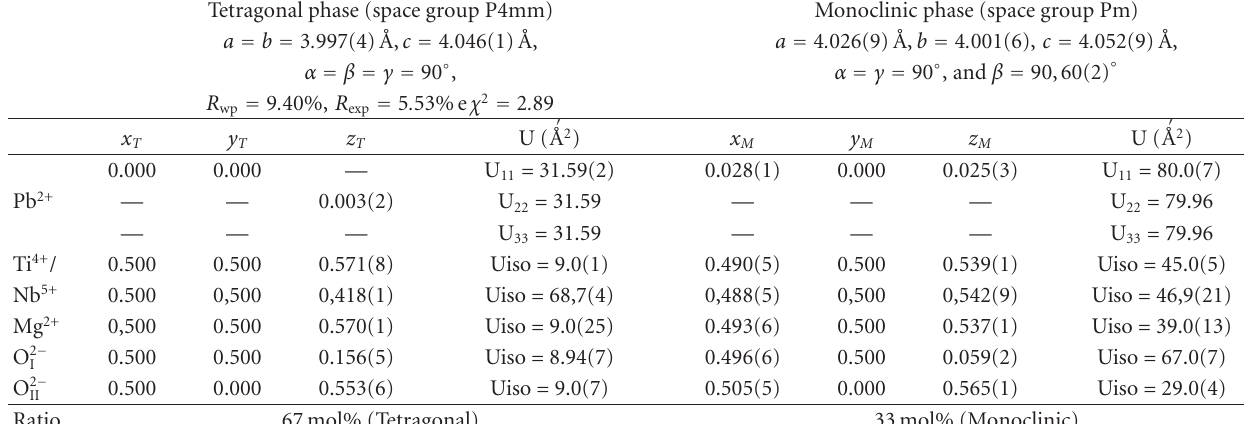
Table 1: Refined structural parameters of PMN-35PT ceramics using the coexistence model between tetragonal phase (space group P4mm) and monoclinic phase (space group